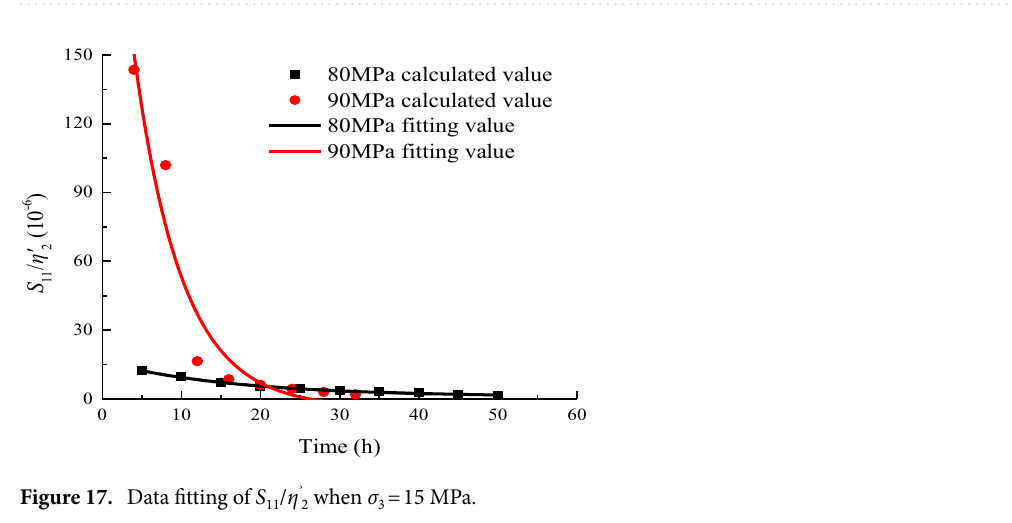
Figure 17. Data fitting of S 11 / η ’ 2 when σ 3 = 15 MPa.